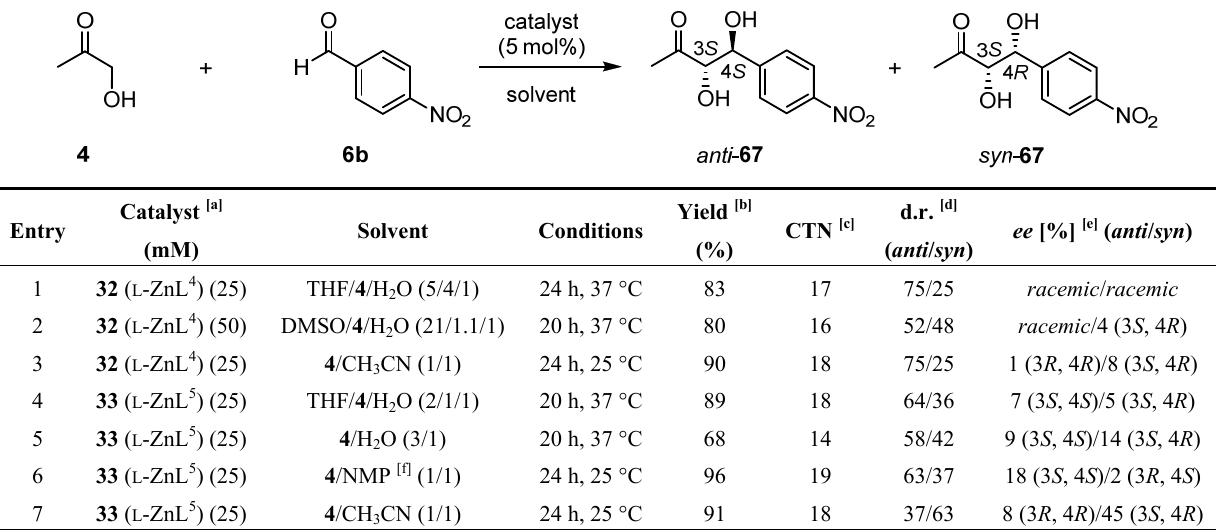
Table 6. Results for an asymmetric aldol reaction between 4 and 6b catalyzed by 32 ( L -ZnL 4 ) and 33 ( L -ZnL 5